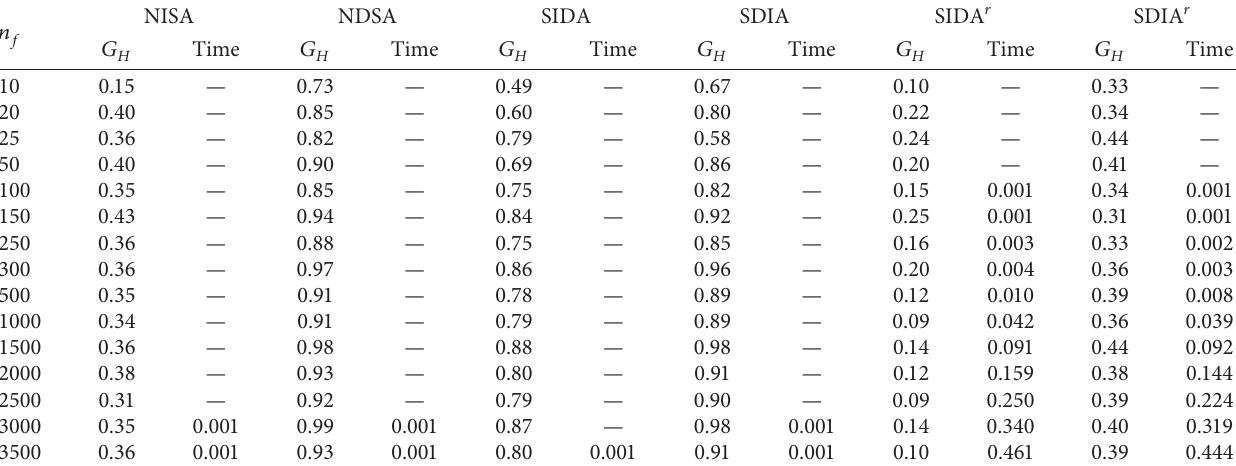
Table 8: The behavior of G H and time when the number of files is changed.